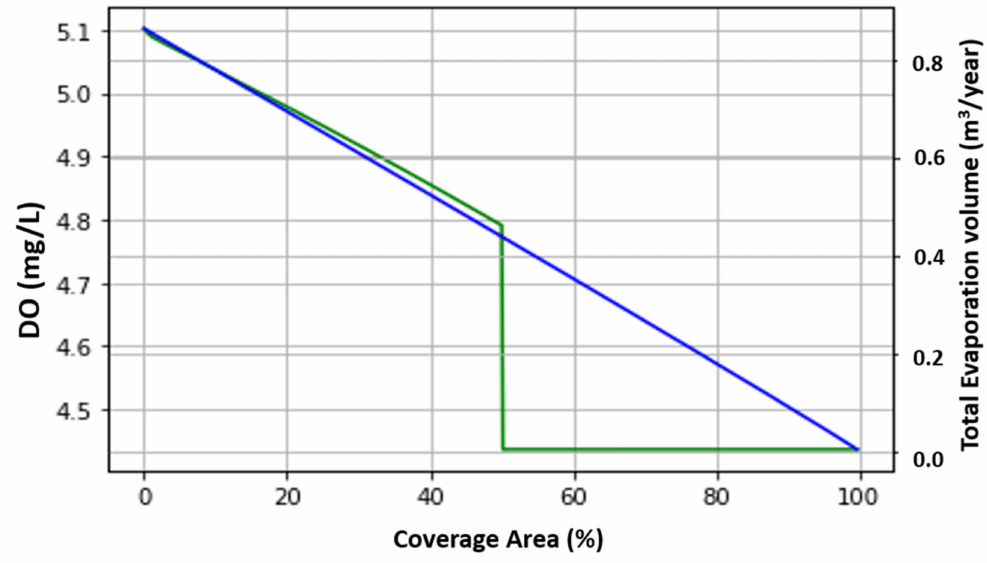
Figure 14. Case (b): The relation between no. of panels, DO, and evaporation volume by applying the condition of DO concentration of 4 mg /